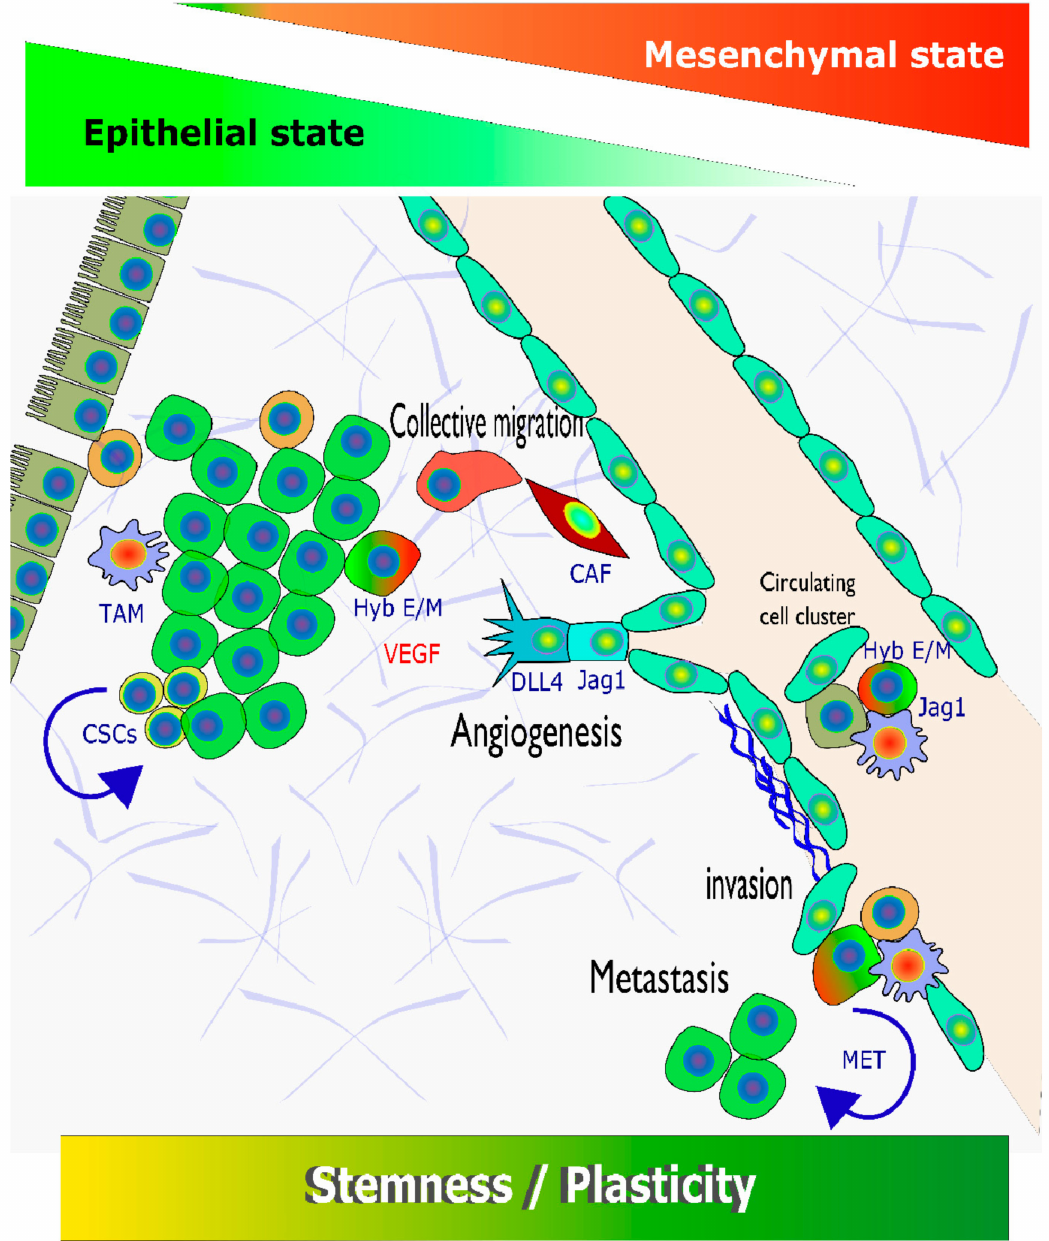
Figure 7. Spectrum, or phenotypic continuum of dynamic, cancer-relevant processes promoted by Notch signalling that result in various aspects of tumour cell plasticity. The transgression between epithelial and mesenchymal states, also towards increased stemness, represents a dynamic process that is influenced by a plethora of internal (genetic, epigenetic) and external (ECM, TME, growth actors, and cytokines) factors.3.3. Specific Features and Drivers of EMT in Squamous Cell